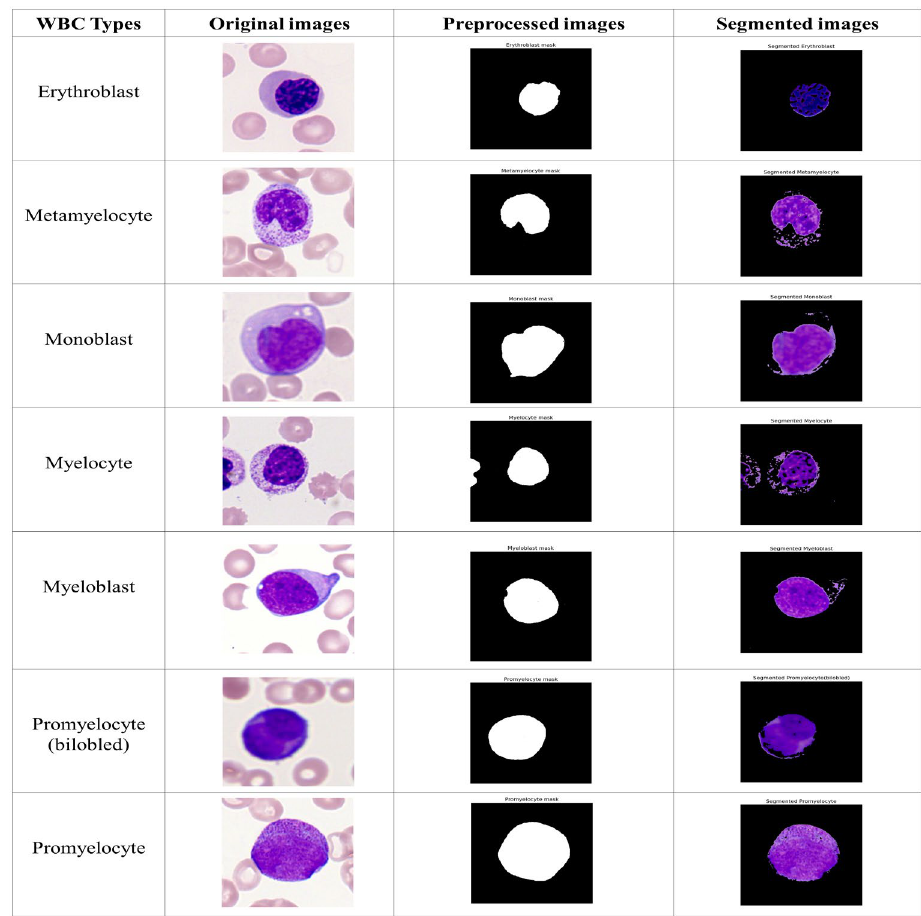
Figure 6. Visualization result on single-cell morphology dataset.